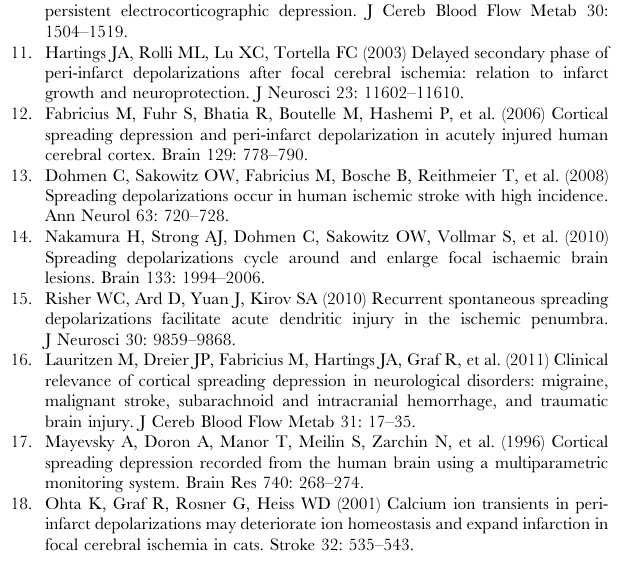
Table S1 Patients in this study. Notes: FCD, focal cortical dysplasia [classification from: [59] Palmini A, Najm I, Avanzinin G et al. Terminology and classification of cortical